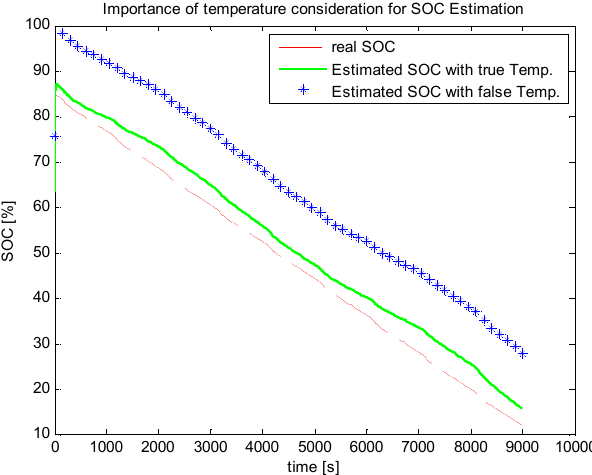
Figure 9. Importance of temperature consideration for UKF-based SOC estimation. When temperature information is discarded, large errors